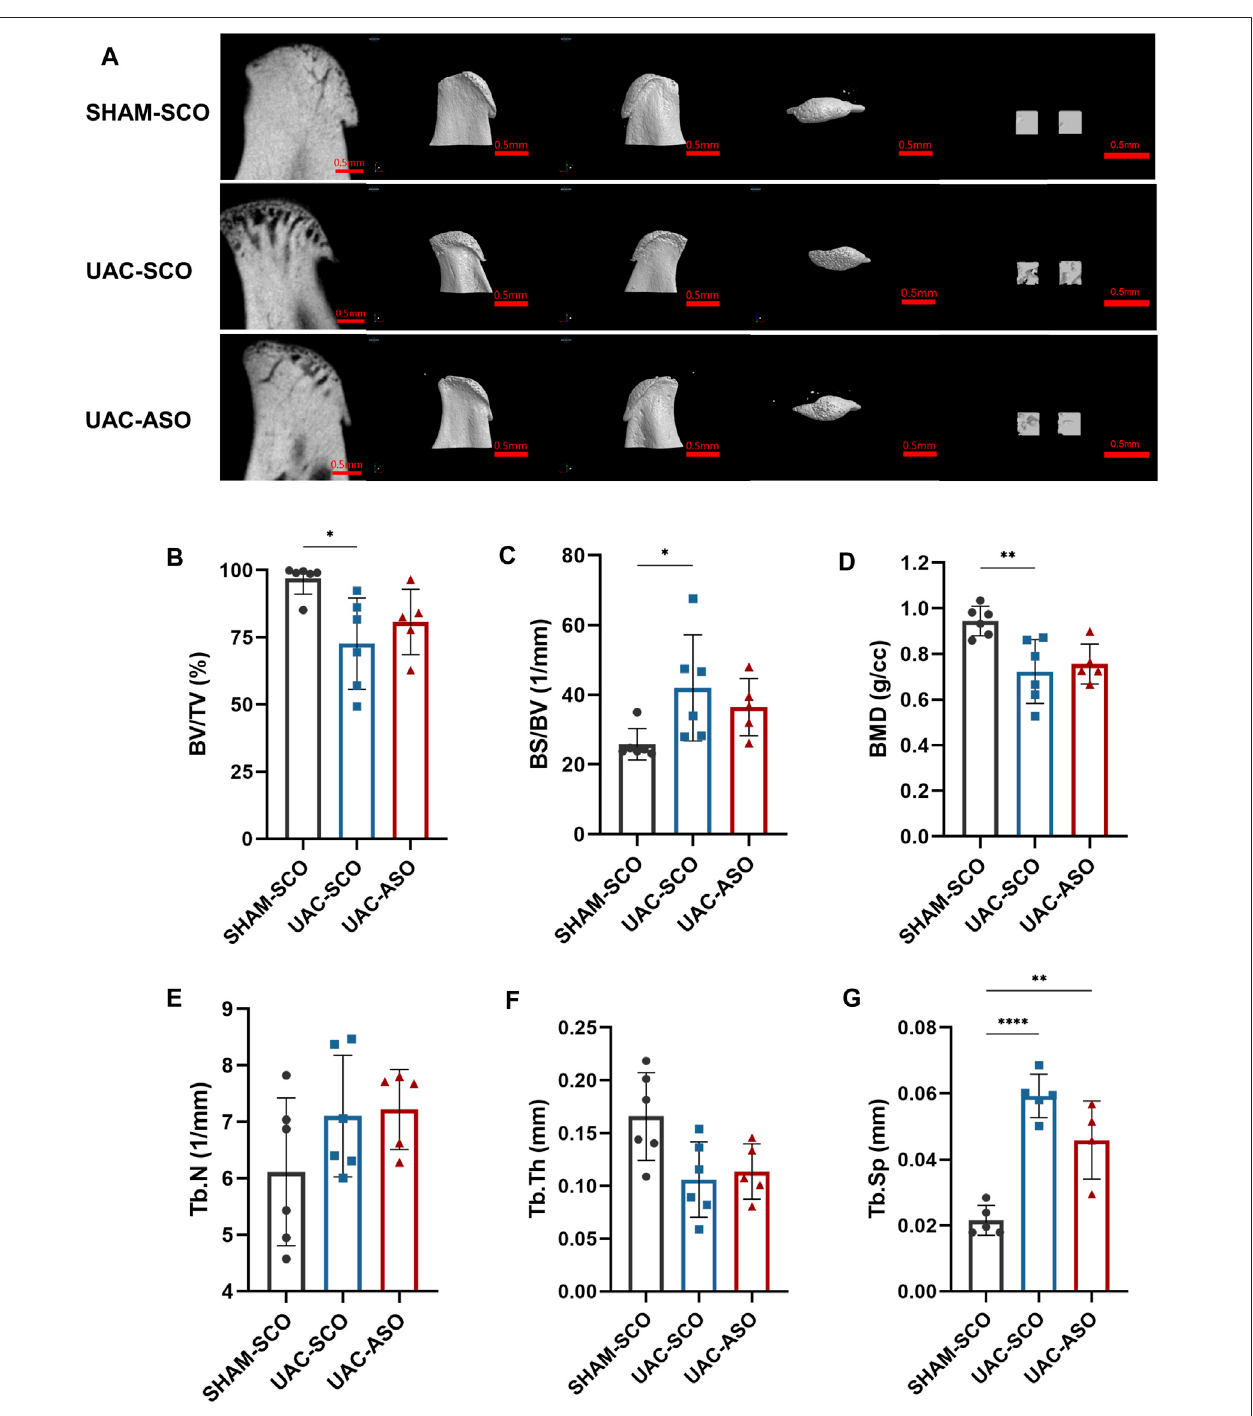
FIGURE7| MiR-181a-5pASOinjectionrestoredthecondylarSubchondralBoneQualityinTMJOA. (A) Representativemicro-CTimagesofcondylarheadandthe selected region of interest (ROI) in SHAM-SCO, UAC-SCO and UAC-ASO mice. For left to right on each row: 2D median sagittal section view, 3D lateral view of left and right side and 3D top-view, 3D reconstruction of the two ROI. For visual comparison, condylar heads in (A) are adjusted to the same orientation. Scale bar = 0.5 mm. (B – G) Micro-CT data analysis of subchondral bone structure parameters of condyle in the SHAM-SCO, UAC-SCO and UAC-ASO groups. n = 6/ group. (B – G) DatapresentedasScatterdotplotwithbar(mean±SD). (cid:1) Statisticalanalysiswasperformedusingone-wayANOVAwithaTukey ’ smultiplecomparisonstest.* p < 0.05; ** p < 0.01; *** p < 0.001; **** p < 0.0001.